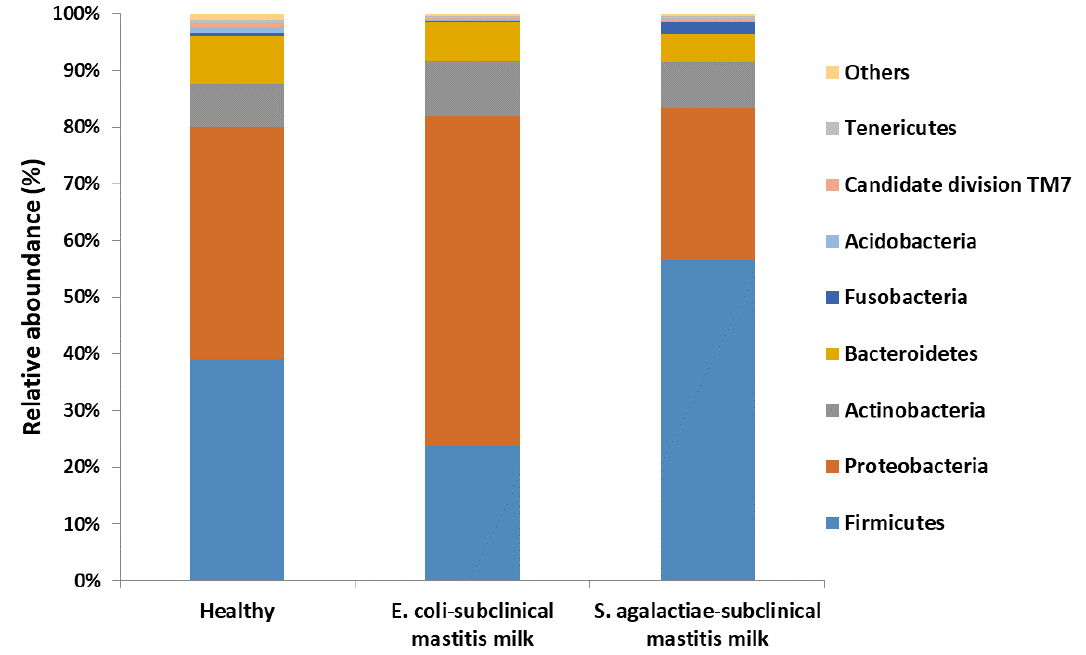
Figure 1. The relative abundance of bacterial phyla in milk from healthy cows and cows with sub- clinical mastitis.